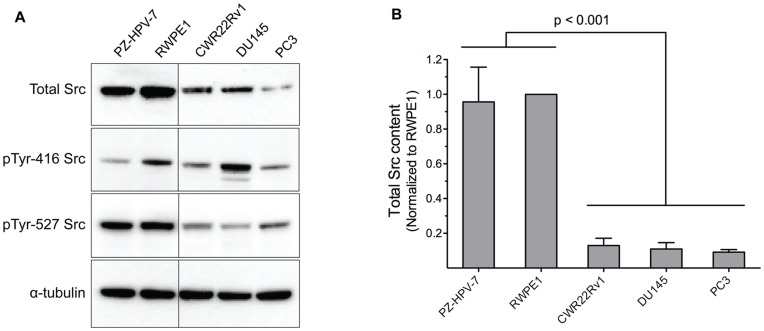
Src expression levels in non-invasive (PZ-HPV-7, RWPE1), androgen-independent (CWR22Rv1), and invasive (DU145, PC3) cell lines.(a) Prostate cell lysates were probed for total Src, pY416 Src and pY527 Src, where α-tubulin was used as the loading control. (b) Intensities of each band from the western blots were measured and normalized to the corresponding α-tubulin control, and then compared to cell line RWPE1 (RWPE1 as 1). Comparison between non-cancer (PZ-HPV-7, RPWE1) and aggressive cancer cell lines (CWR22Rv1, DU145, PC3) showed significant lowered levels of Src expression in the latter (p<0.001). Data are representative of at least three independent experiments and are mean with SEM.